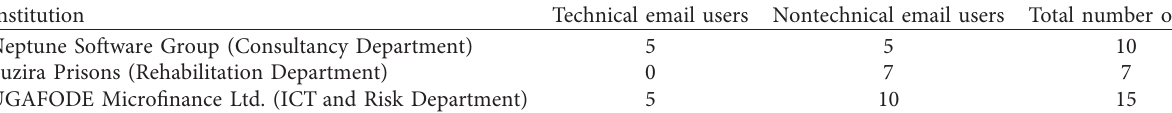
Figure 1: Methodology approach. Table 1: Sample size of the population.